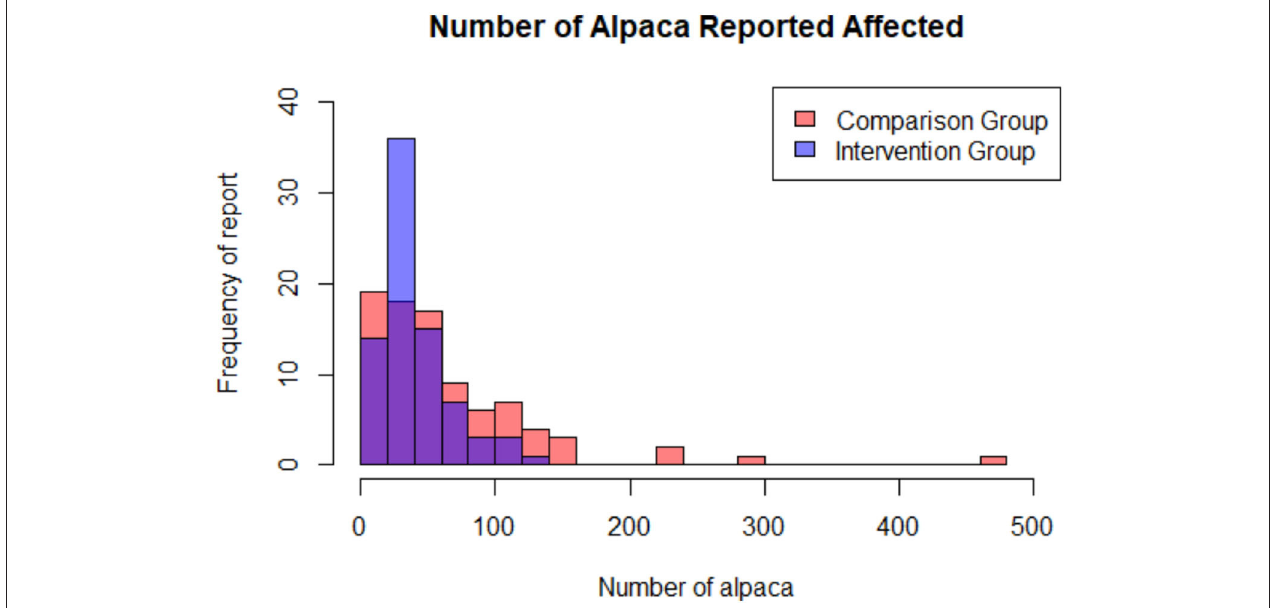
FIGURE 4 | How many alpacas were reported by each household as affected by the extreme